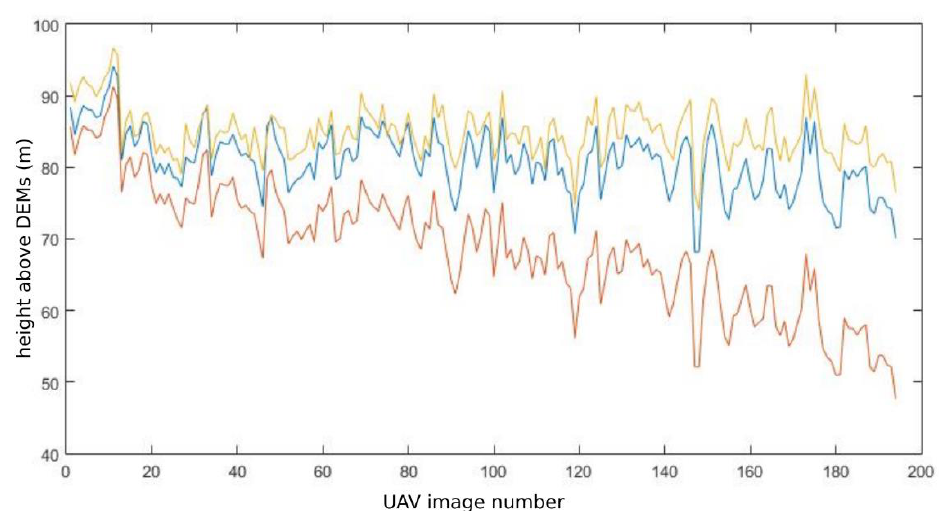
Figure 14 . Heights above the fake DEM (blue), heights above the tilted fake DEM (red) and barometric heights (orange) above the fake DEM.